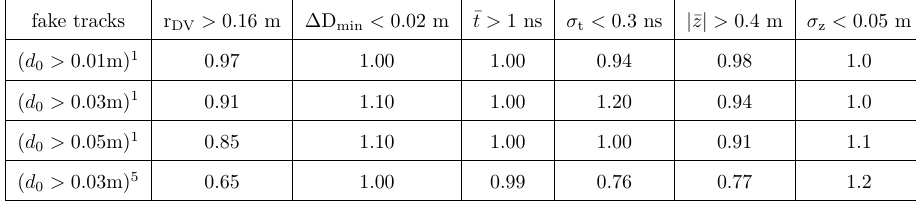
Table 4 . The correlation between vertexing-cuts and d 0 cuts for fake-track